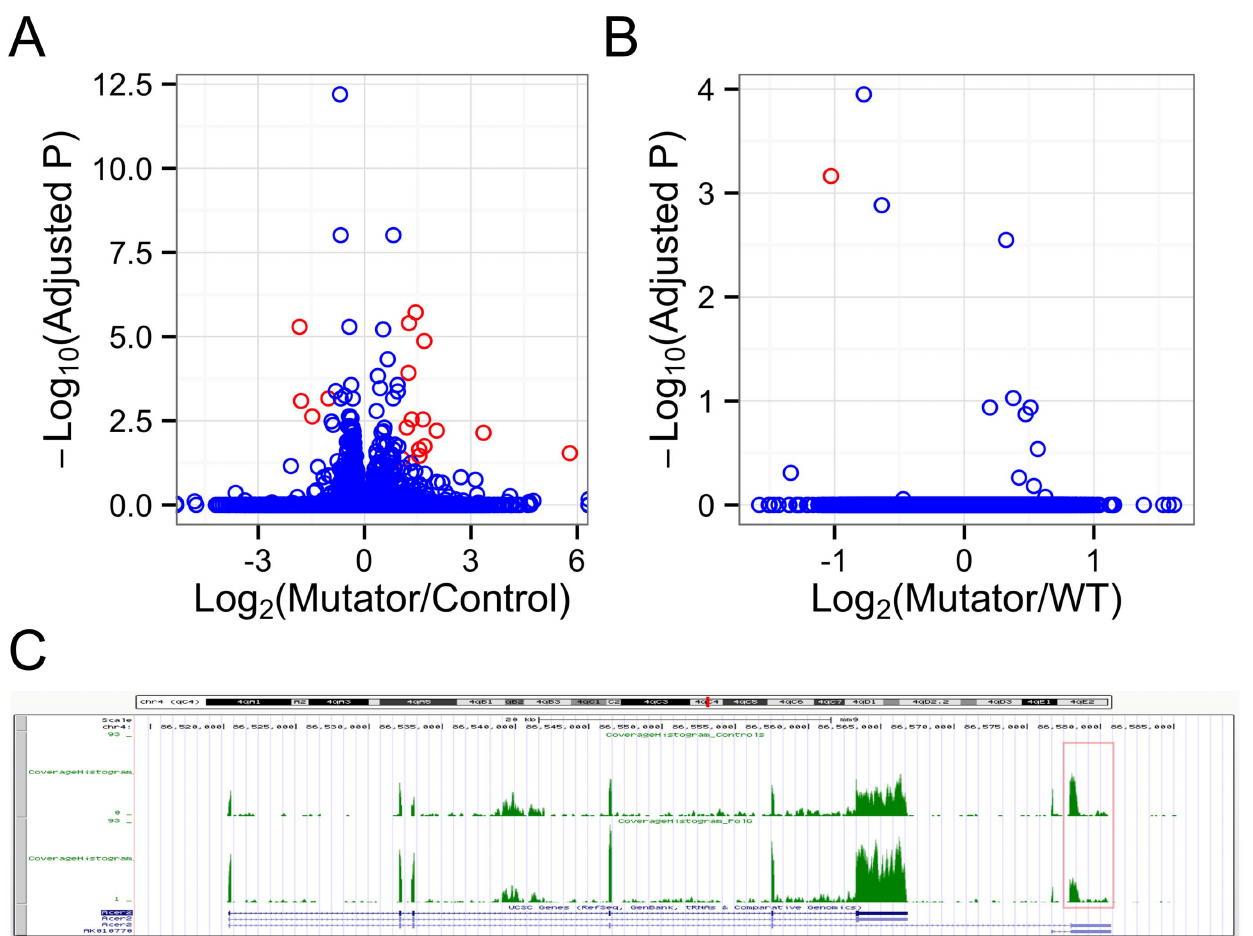
Figure 4. RNA-Seq data. A) Volcano plot of DESEQ results showing gene expression changes. Genes that were changed greater than 2-fold and statistically significant are colored red (n=4 controls (3 WT/WT and 1 WT/D257A), n=7 mutator). B) Volcano plot of DEXSEQ results showing differential exon usage. Exons that were statistically significant and changed greater than 2-fold are shown in red (n=3 WT/WT, n=7 mutator). C) UCSC Genome Browser read count histogram for Acer2. Overall expression of this gene was significantly increased in Polg mutator mice, but usage of an alternative 5 9 UTR (boxed in light red) was significantly decreased in the mutator mice.